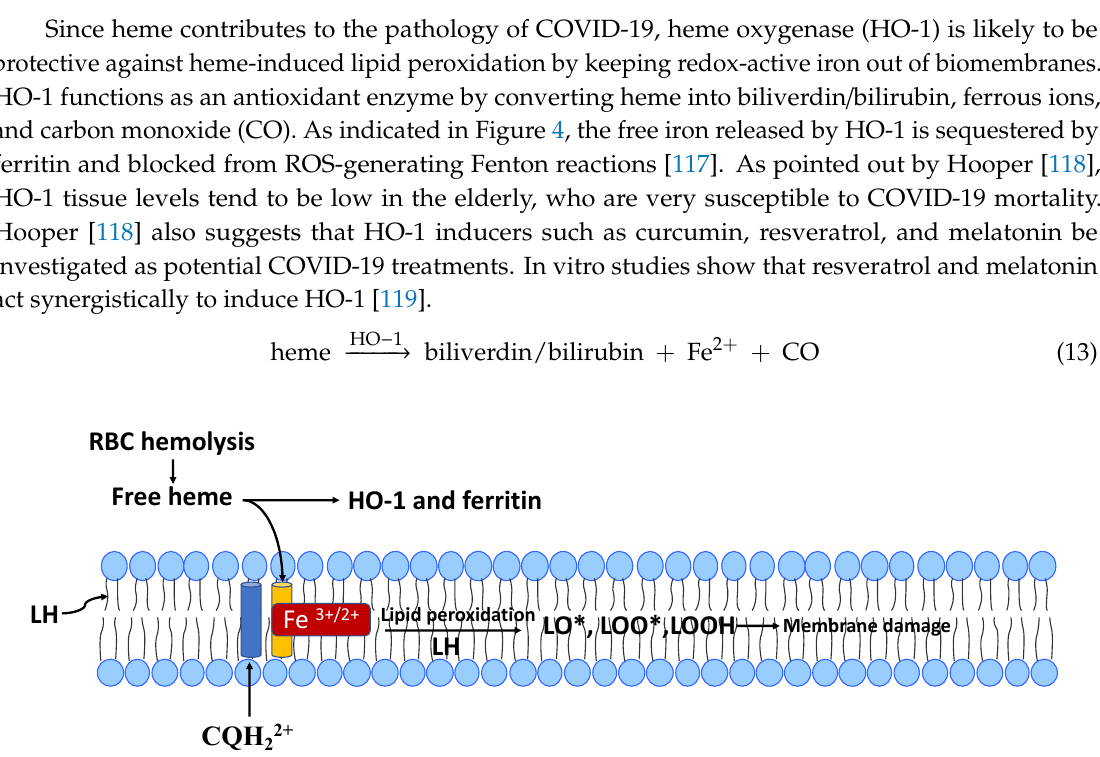
Figure 4. Chloroquine (CQH 22 + , blue cylinder)) form a membrane-bound complex with heme (orange cylinder with Fe 3 +/ 2 + ) that promotes the peroxidation of phospholipids with polyunsaturated fatty acids (PUFAs or LH). Reactive lipid species (LO • , LOO • and LOOH) from lipid peroxidation can damage both biomembranes and membrane-bound proteins. Heme, in the absence of CQ can also cause lipid peroxidation, but this process is markedly amplified by formation of the CQ-heme complex (see text). RBC hemolysis and / or dysfunction of mitochondrial heme metabolism can produce free heme. If not metabolized by hemeoxygenase-1 (HO-1), and the released iron sequestered by ferritin, lipophilic heme can bind to biomembranes.